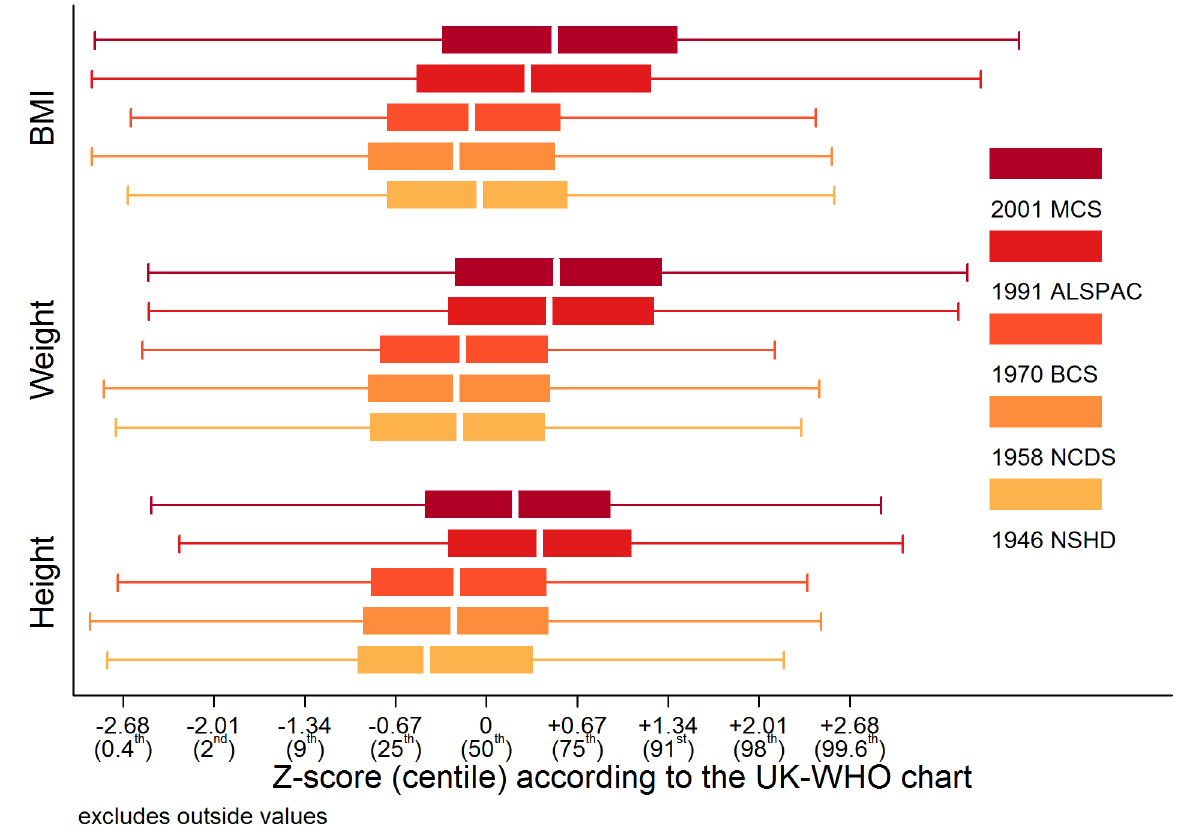
Fig 4. Study-stratified box plots for height, weight, and BMI Z-scores according to the UK-WHO chart at 10 or 11 years of age. BMI: Body Mass Index, UK-WHO: United Kingdom-World Health Organisation, NSHD: Medical Research Council National Survey of Health and Development, NCDS National Child Development Study, BCS: British Cohort Study, ALSPAC: Avon Longitudinal Study of Parents and Children, MCS: Millennium Cohort